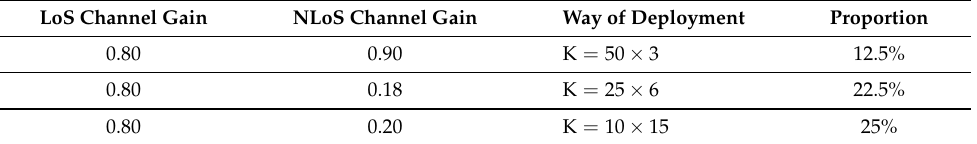
Table 3. Numerical Values of LoS and NLoS links with different deployment of